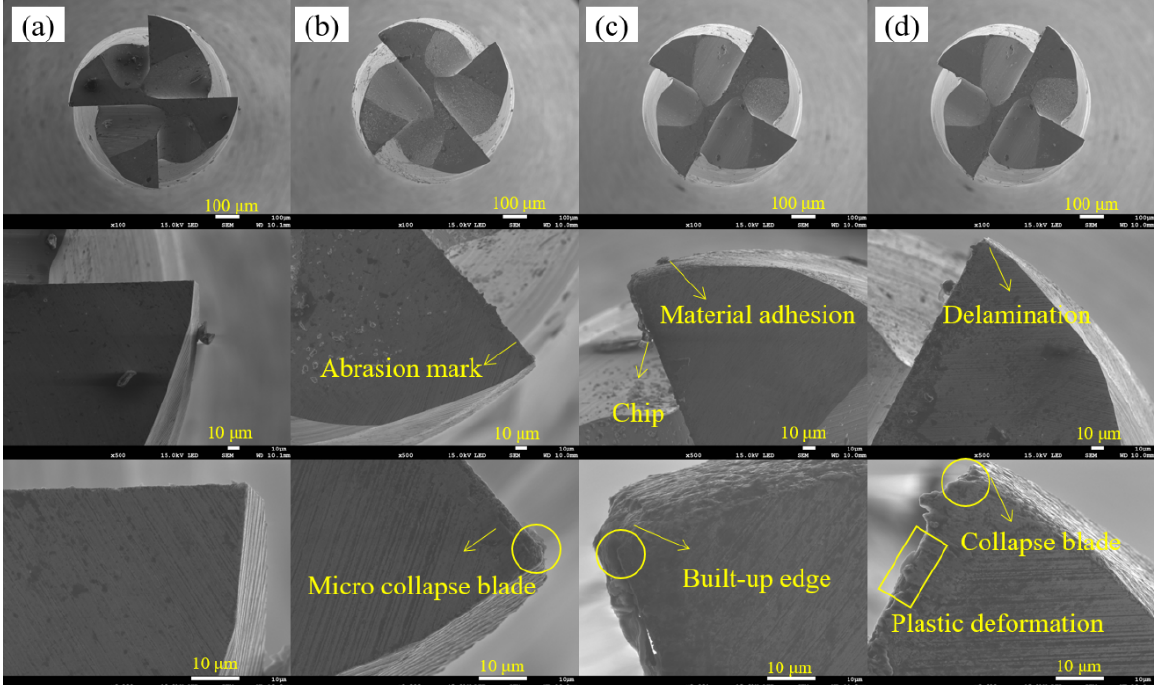
Figure 8. SEM image analysis of micro-milling cutter under different wear states. ( a ) Initial’s 100/500/2000 × image, ( b ) Wear I’s 100/500/2000 × image, ( c ) Wear II’s 100/500/2000 × image, ( d ) Wear III’s 100/500/2000 × image.